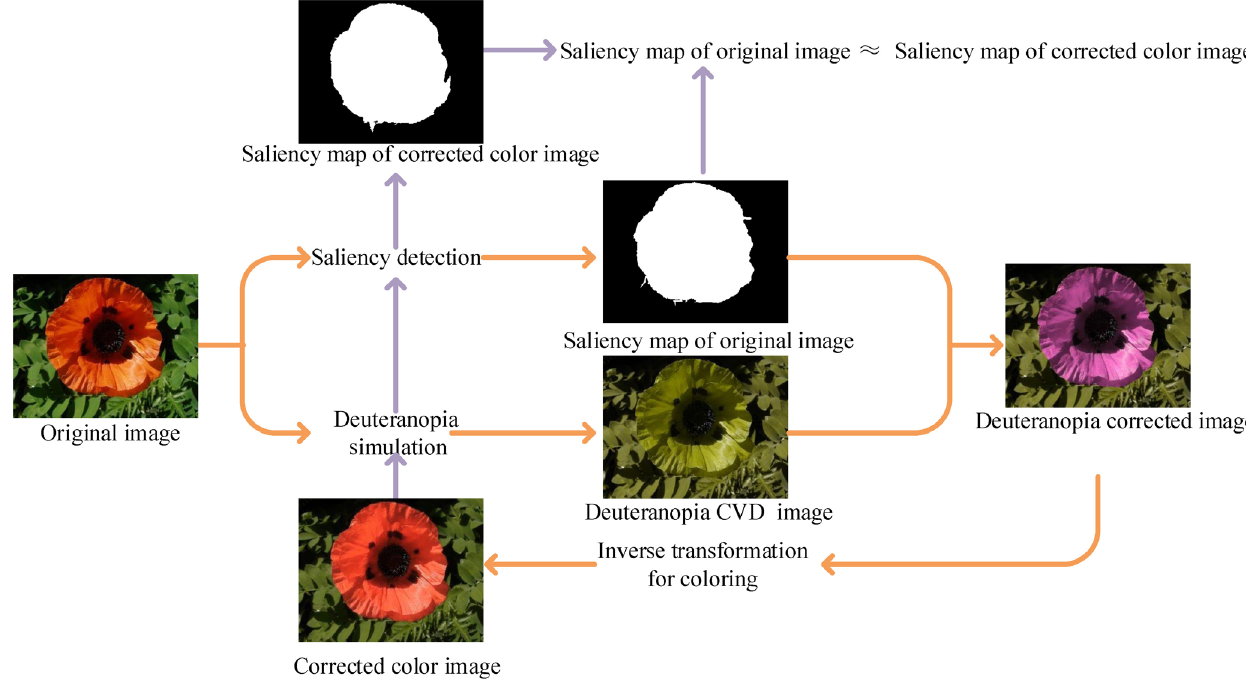
Fig. 4 Pipeline of our proposed saliency-based image correction algorithm for colorblind